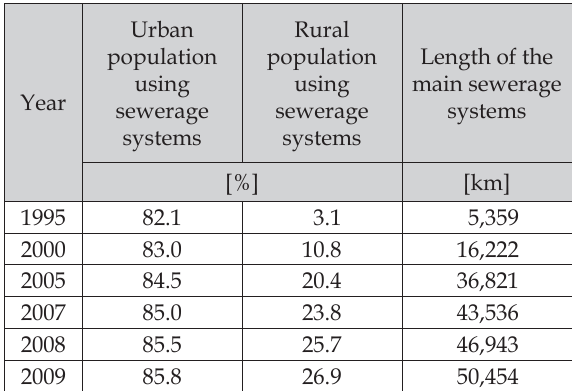
Table 1. Use of the main sewerage systems in